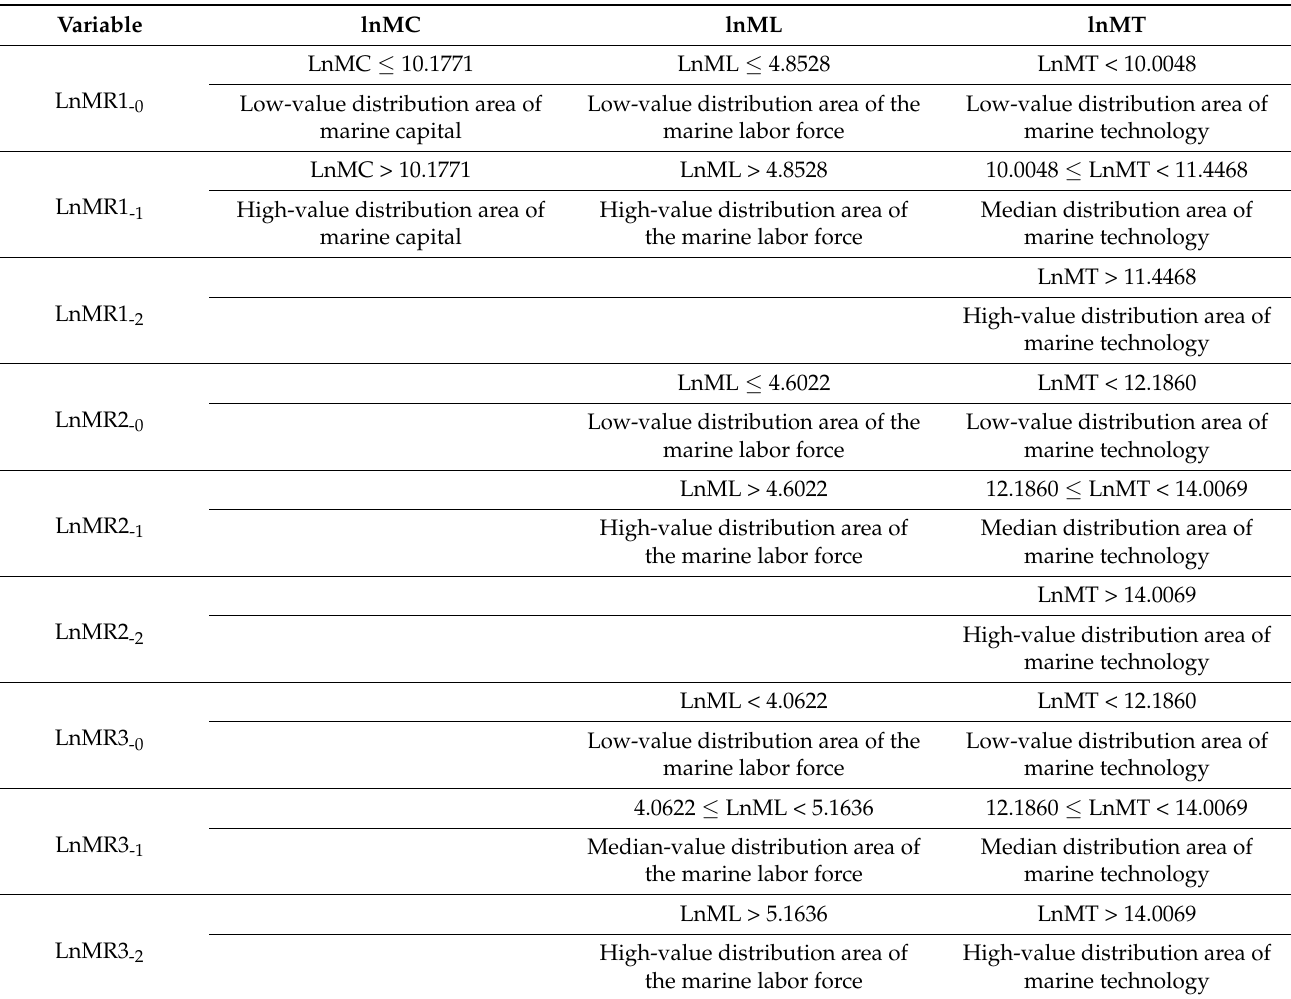
Table 5. Interval division of the estimation result of the threshold value of marine resources and economic